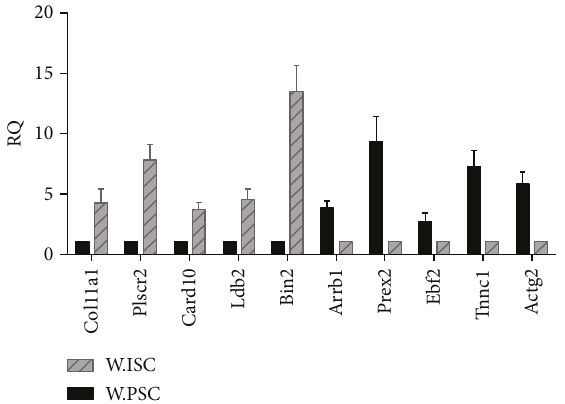
Figure 5: Validation of mRNA-seq to validate the 10 di ff erential expression genes by real-time PCR. Black bars represent the gene expression levels of Wistar rats ’ PSCs while gray bars represent the relative gene expression levels of Wistar rats ’